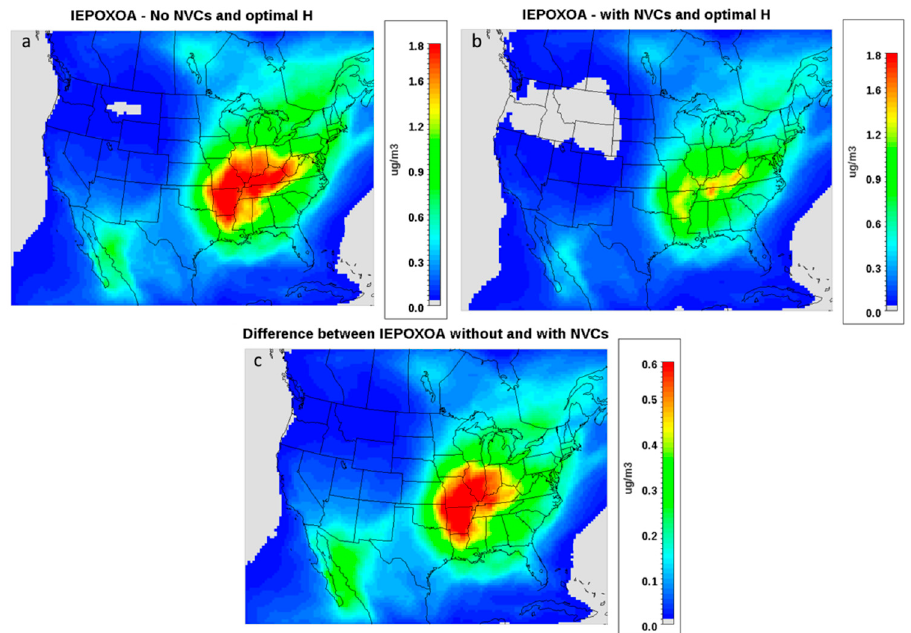
Figure 7. Campaign average predicted IEPOX OA when non-volatile cations (NVCs) are excluded ( a ) and included ( b ) in the simulations, as well as the difference ( c ) between the two fields. Simulations for these cases are carried out with all the code updates active.